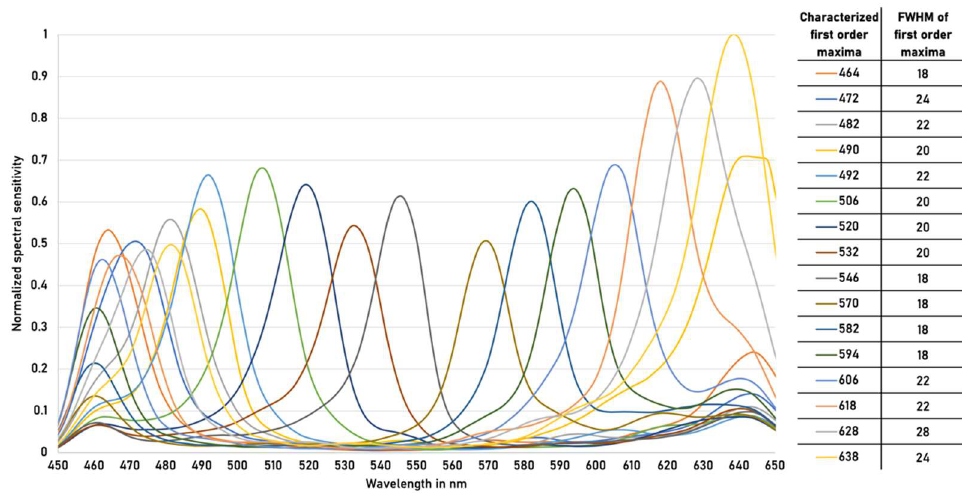
Figure 2. Characterized spectral sensitivity curves and their properties of snapshot-mosaic camera. After connecting the snapshot-mosaic camera with the software using the updated .xml calibration file bright and dark reference images must be acquired as a first step before the actual processing. For setting up the multivariate data processing and spectral model building, different cell samples have been acquired, and the spectral model have been trained. The measurement image acquisition is done as a transmission image. This is a common standard in UV-VIS spectroscopy. For correct referencing, a bright and dark adjustment is performed to interpret the measurement image as a transmission image shown in Equation (1).